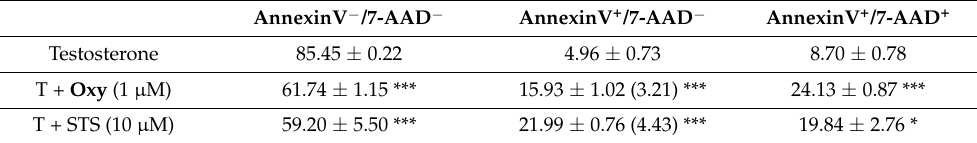
Table 3. Effects of Oxy on Annexin V-FITC labelling in MCF-7aro